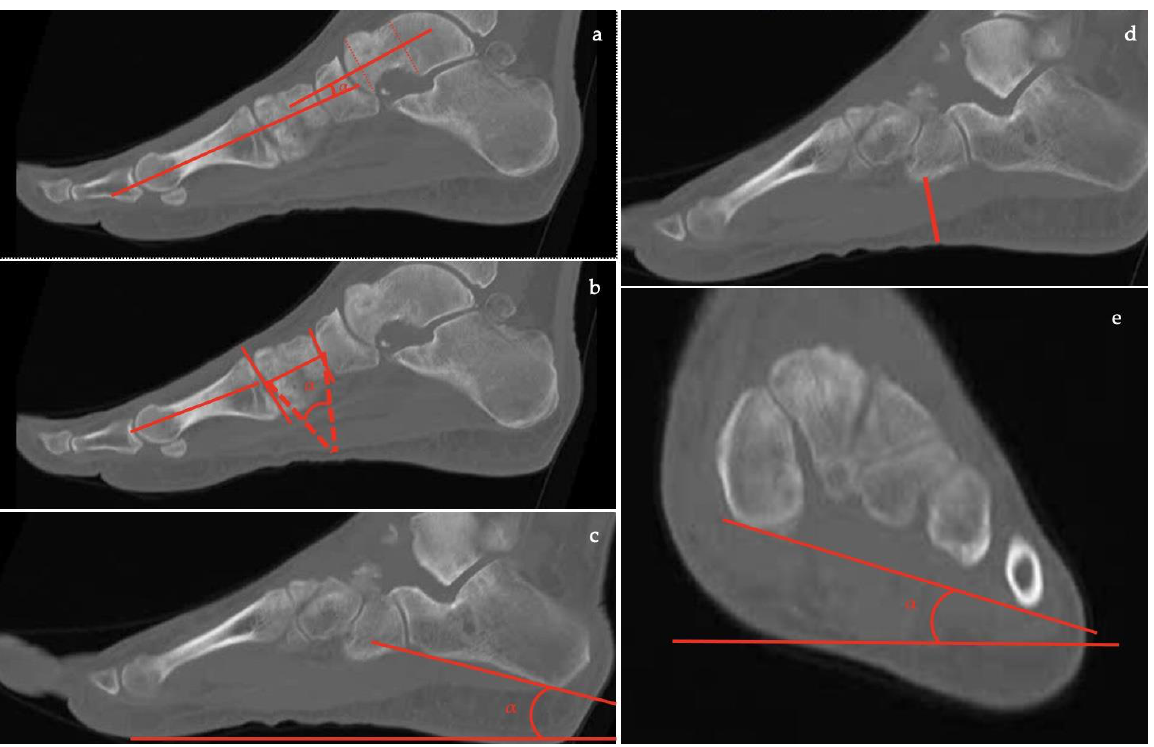
Figure 12. Computed Tomography (CT) imaging: ( a ) Talar–first metatarsal angle (Meary’s angle), ( b ) Medial Cuneiform-First metatarsal angle, ( c ) Calcaneal inclination angle, ( d ) Cuboid to floor distance, ( e ) Forefoot arch angle.